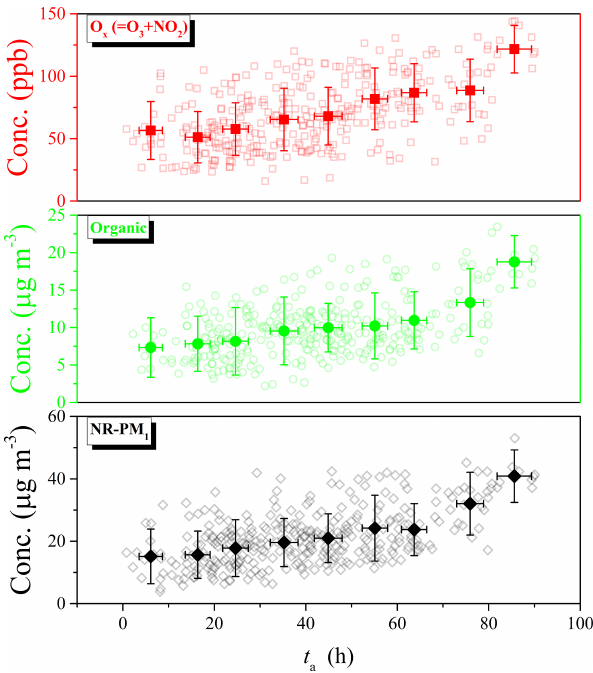
Figure 2. Relationship between photochemical age ( t a ) and total oxidant (O x ), NR-PM 1 concentration, and organic concentration during the observation period included by Cluster 2. The data are binned according to the value of t a (10h increment).